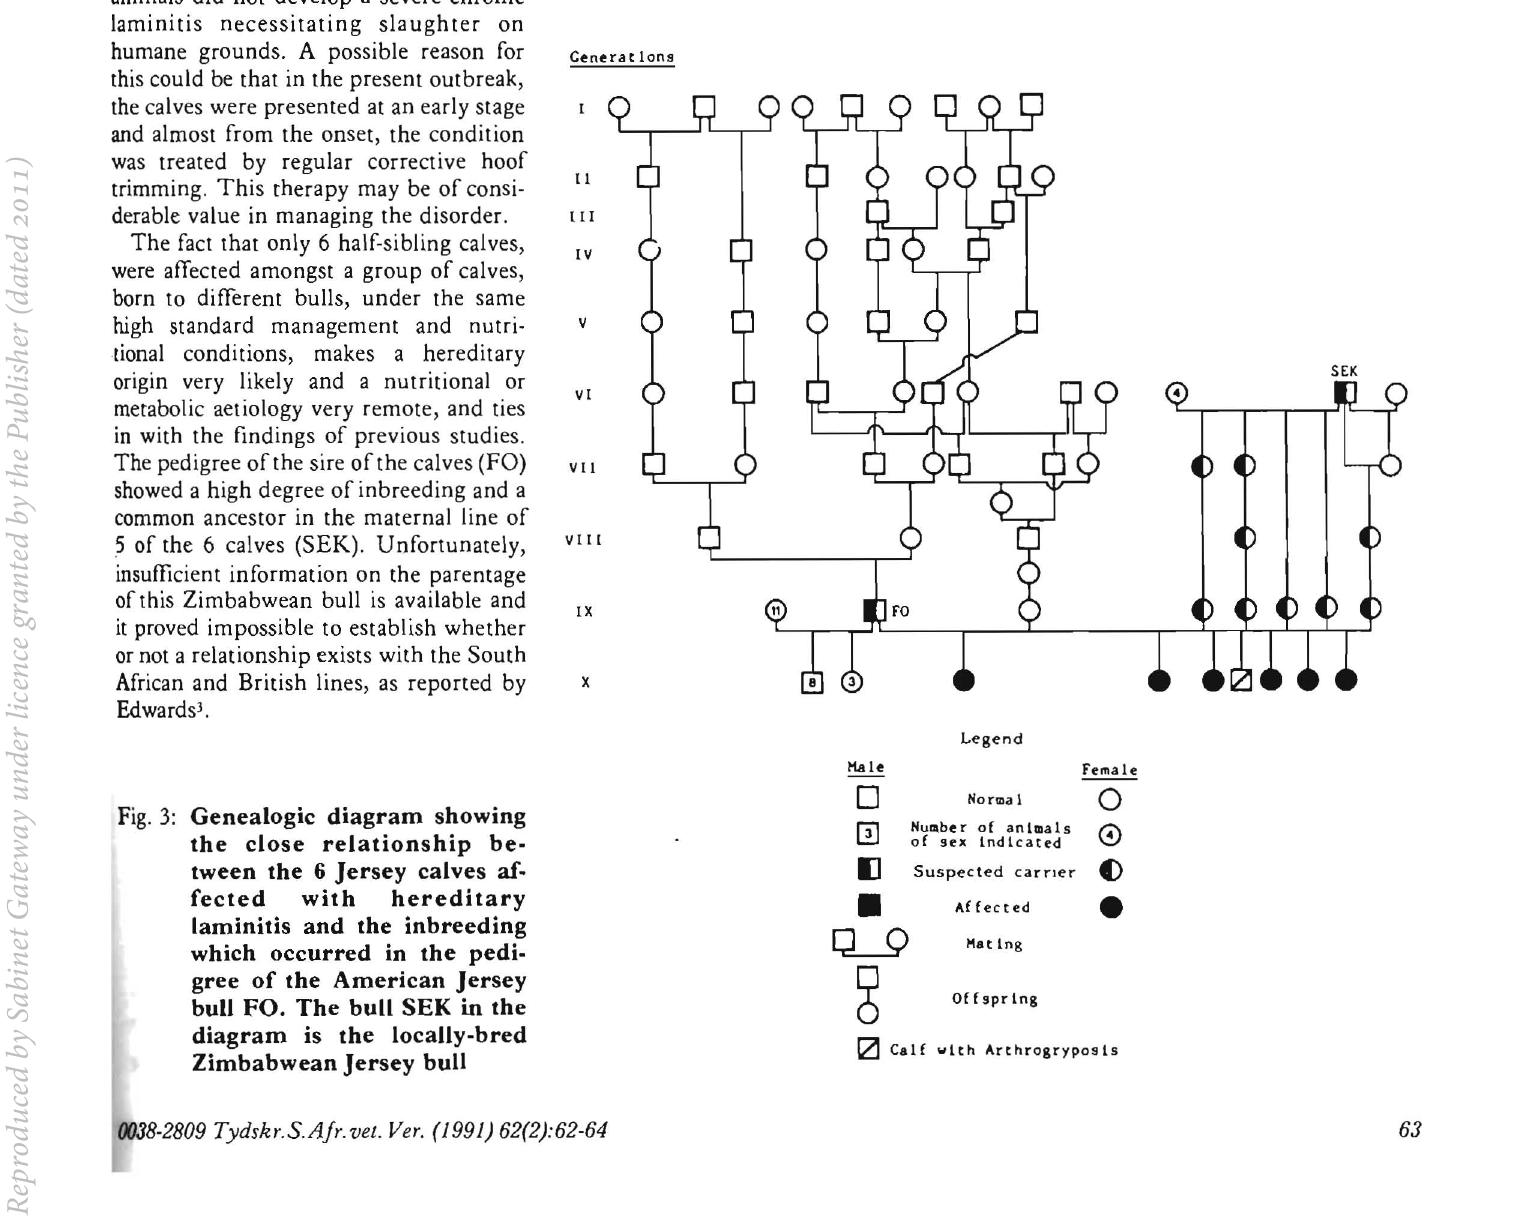
IT] Suspected carner () • • Affected Q...9 Hating ~ Off .pr